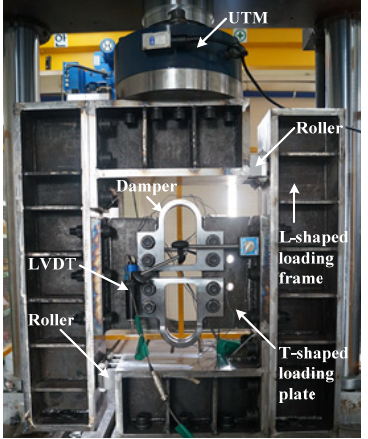
Figure 2. Test setup of specimen.